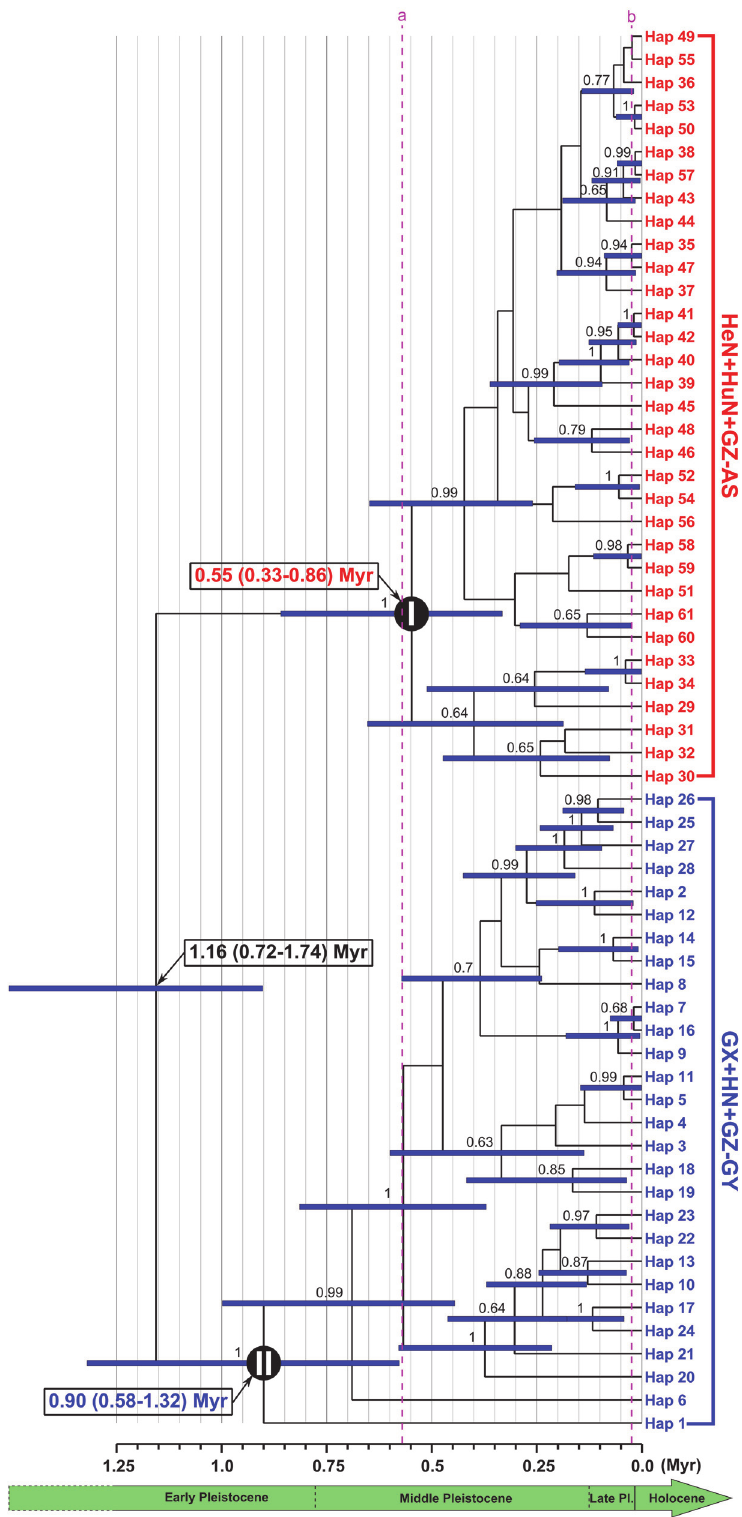
Fig 4. Phylogram of Spirometra erinaceieuropaei isolates from central and southern China with divergence time estimates based on mtDNA haplotypes. Blue bars at each node show 95% highest